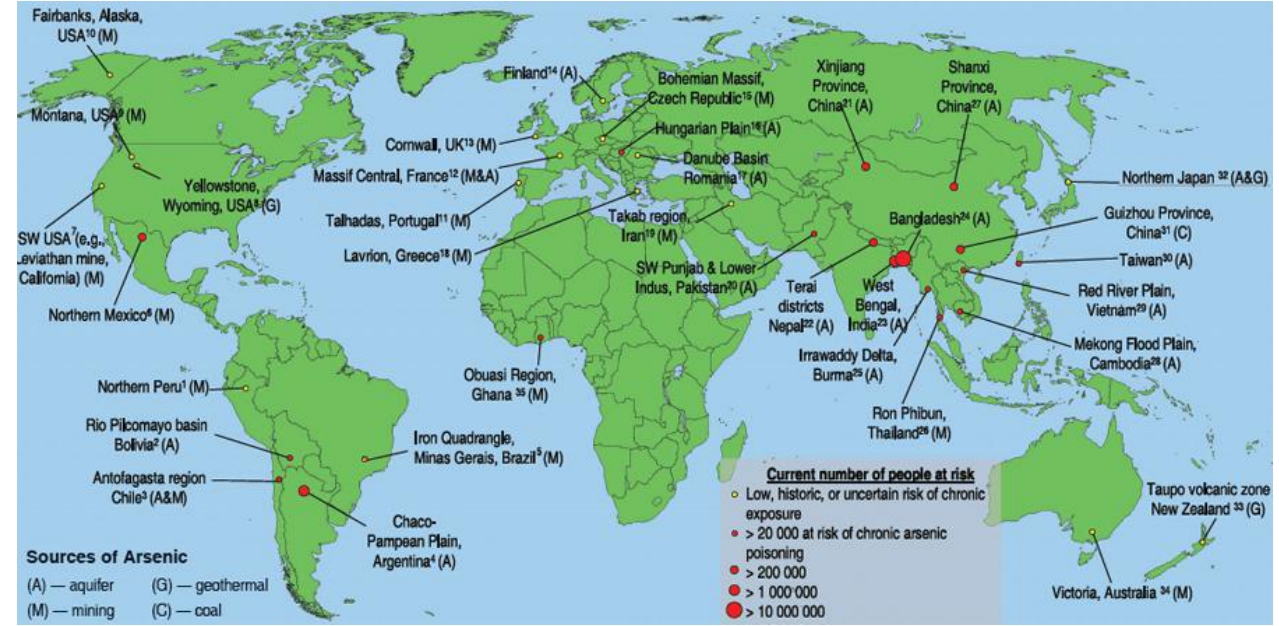
Figure 2. Worldwide distribution of arsenic contaminated regions, showing source of arsenic and numbers of people at risk of chronic